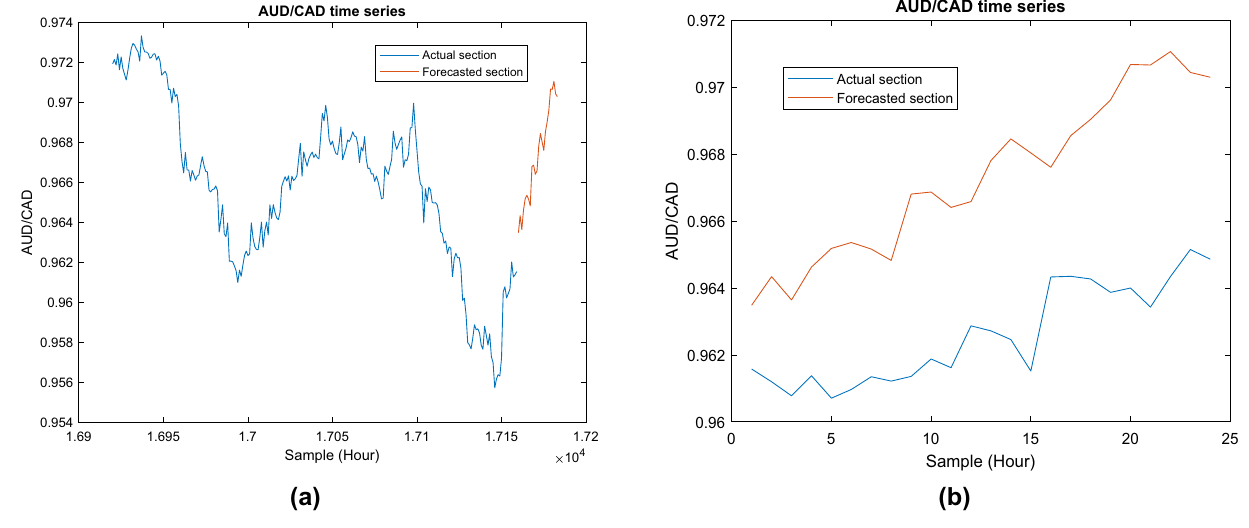
Fig. 8 a Forecasting the upcoming 24 data samples of the AUD/CAD exchange rate using the apriori 120 data samples. b Comparison of the forecasted data [24 samples (hours)] with the actual data. The forecasting accuracy is sharp, with a correlation coefficient of